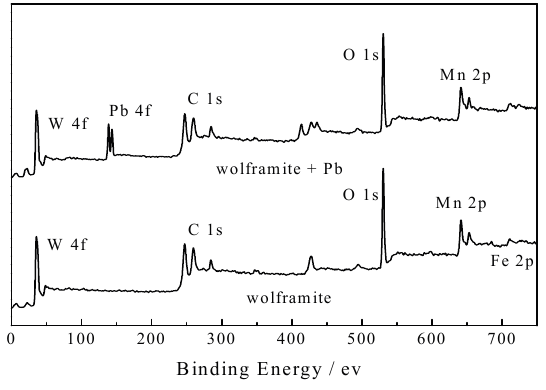
Figure 5. Spectra of atom orbitals for wolframite before and after lead